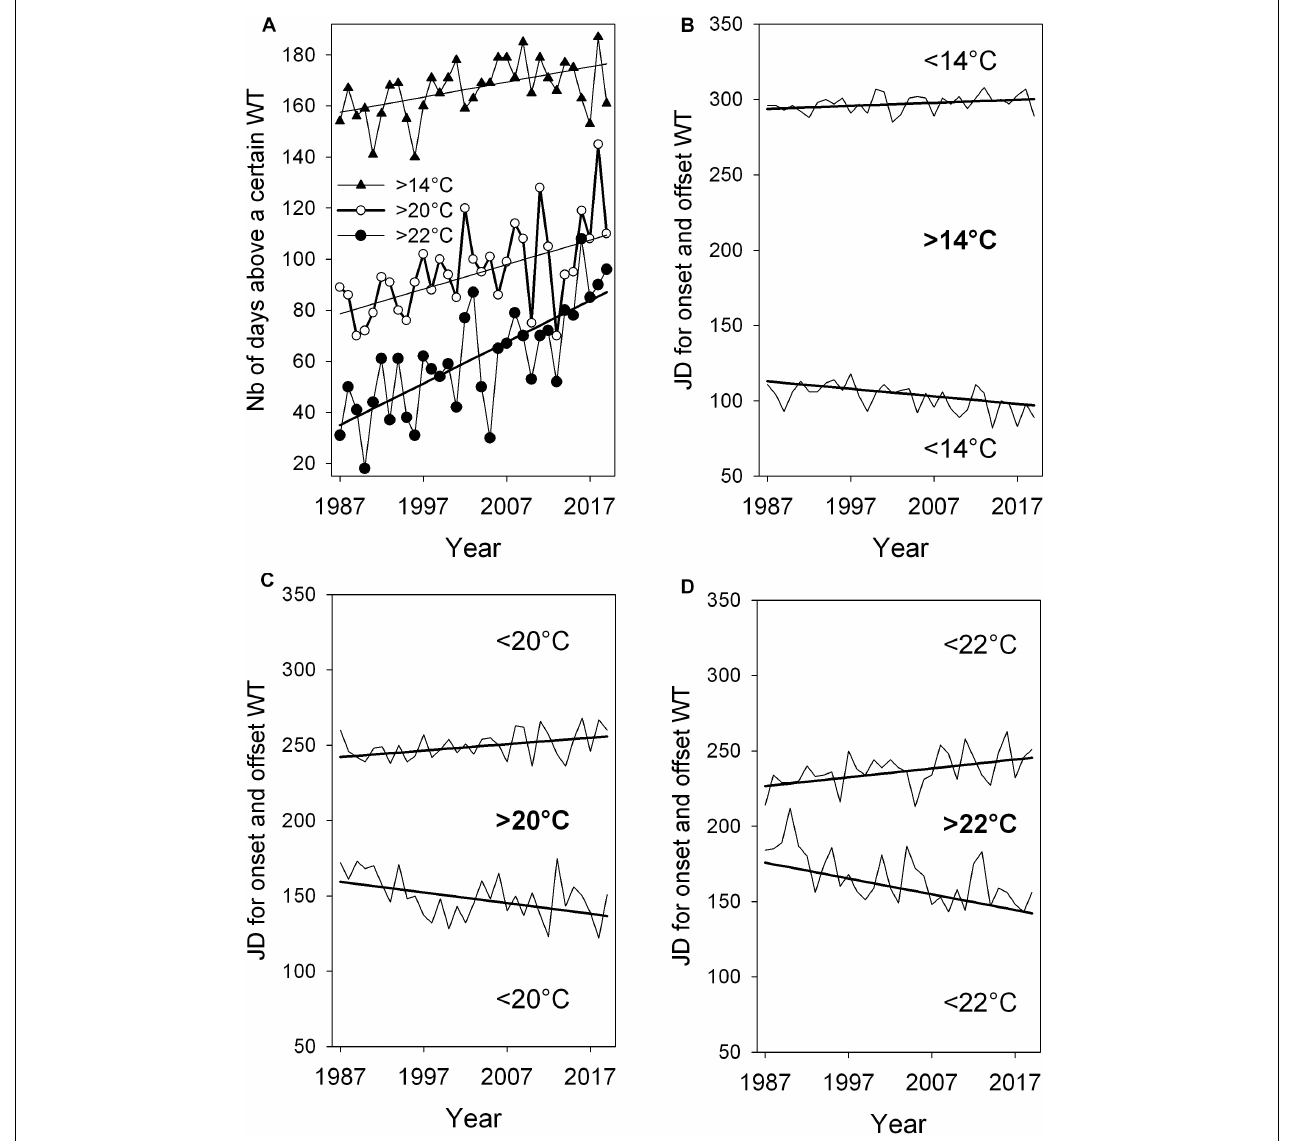
FIGURE 8 | Lengthening of the warm period above three WT values indicated by significant positive slopes of trends with +0.59** for WT > 14 ◦ C, +0.96*** for WT > 20 ◦ C and +1.63*** for WT > 22 ◦ C (A) . Days of onsets and offsets of the three WTs in panels (B–D) . The negative trend slope for onset days in mid spring or early summer is –0.46*** for WT > 14 ◦ C, –0.71* for WT > 20 ◦ C, and –1.05*** for WT > 22 ◦ C. Slope for the offset in late summer or autumn is +0.2* for WT < 14 ◦ C, +0.43* for WT > 20 ◦ C and +0.59* for WT < 22 ◦ C. Significance of robust slopes with * p < 0.05, ** p < 0.01, and *** p < 0.001, Year-to-year time series from 1993 to 2019. The number of days for lengthening period and time shift for onset days above 11 ◦ C, 14 ◦ C, and 22 ◦ C see Table 3